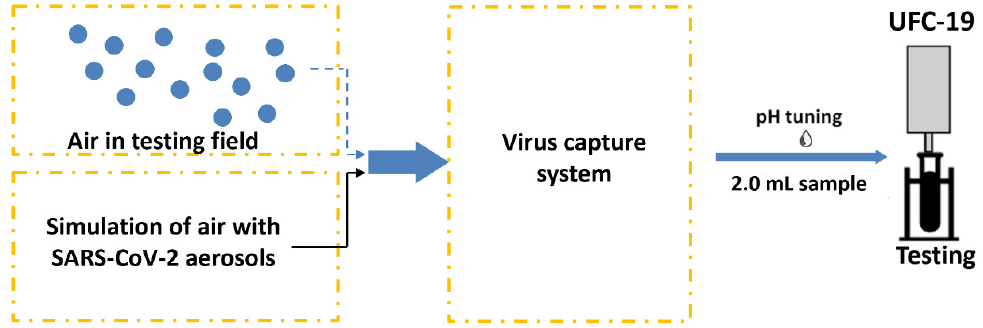
Figure 1. Test rig design capturing and testing SARS-CoV-2 in air. The system includes aerosolization of liquid samples into air to simulate the environment.